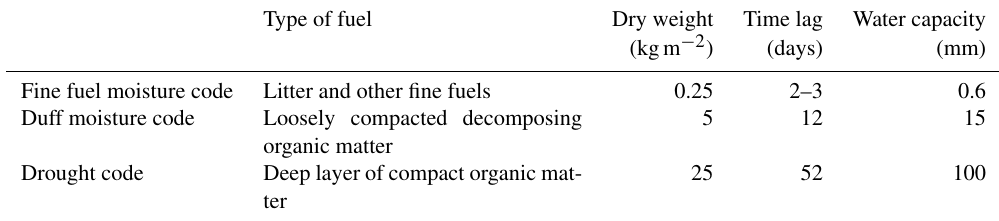
Table A2. The characteristics of the Canadian’s Fire Weather Index’s three fuel moisture